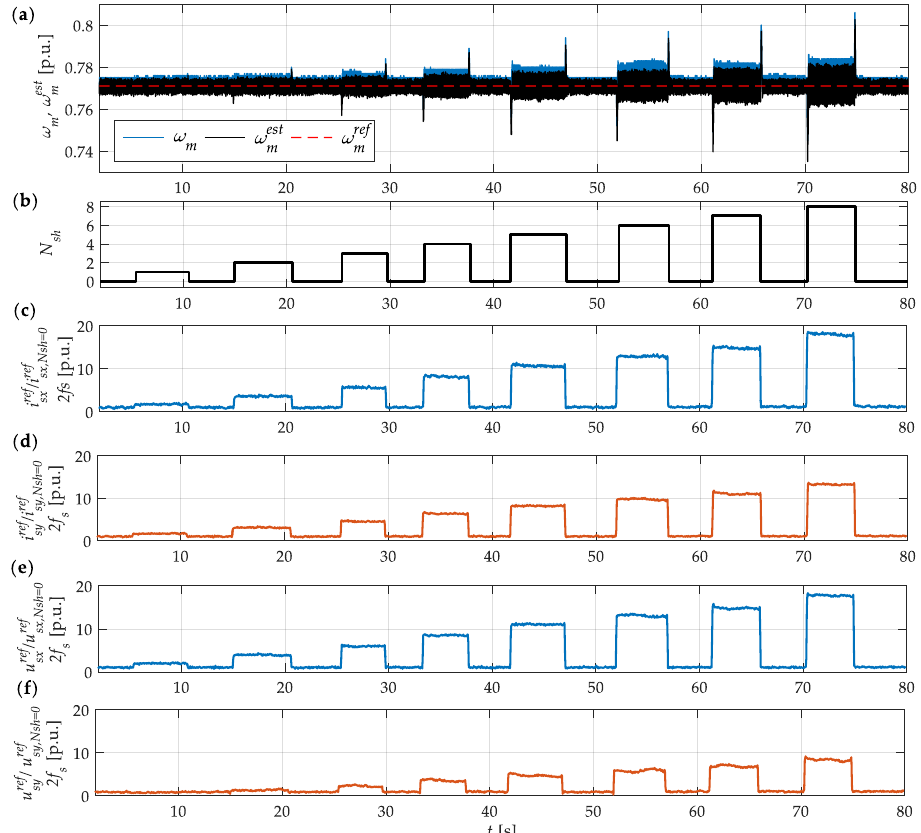
Figure 8. Performance of the speed estimation during the fault and on-line monitoring of diagnostic signals: ( a ) Estimated and real speed; ( b ) number of short-circuit turns—relative changes of the amplitudes of the second harmonic 2 f s of the reference signals; ( c ) field-producing current; ( d ) torque-producing current; ( e ) field-producing voltage; ( f ) torque-producing voltage.